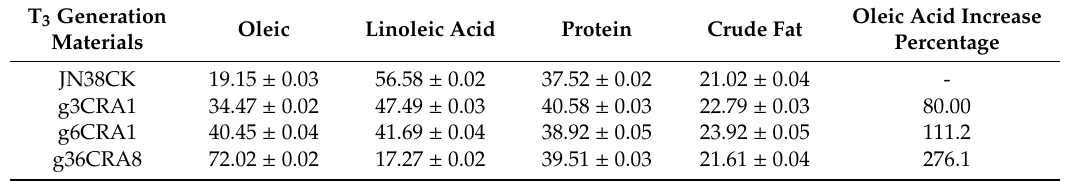
Table 3. Changes in fatty acid composition of positive T3 generation strains.